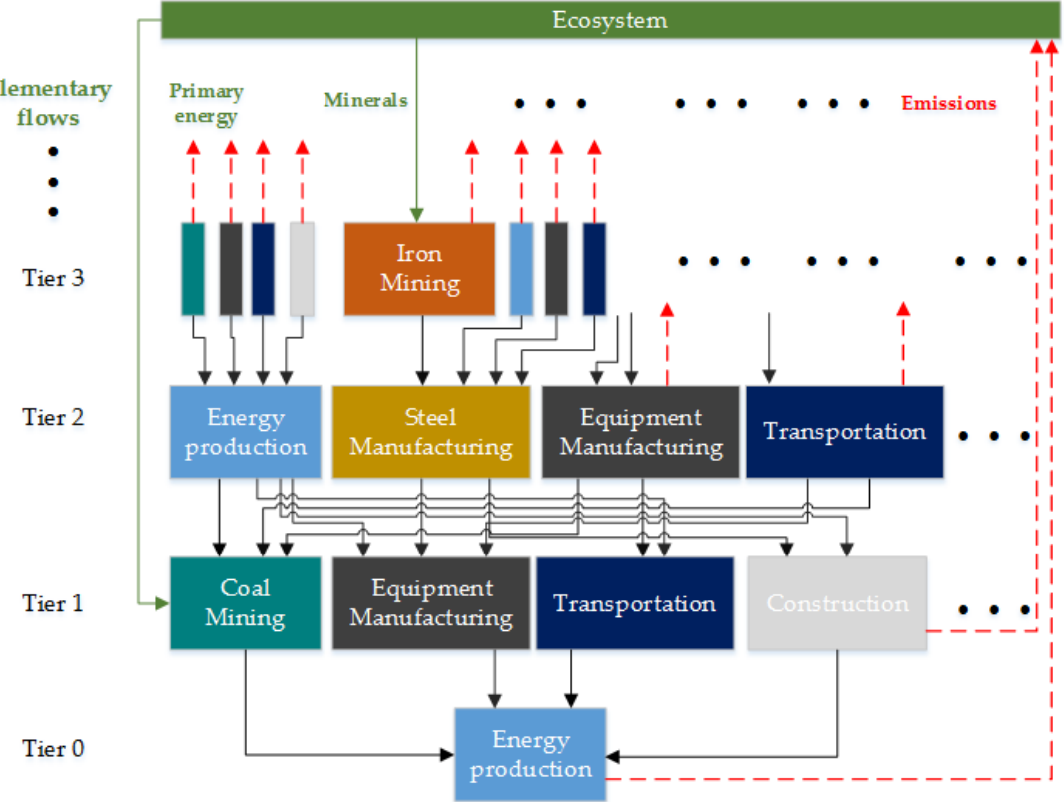
Figure 5. The multi-tiered supply chain associated with energy production.